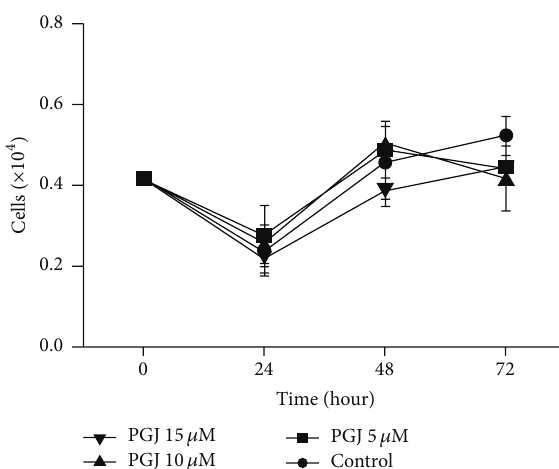
Figure 2: Fibroblast (FG11) cell proliferation under 15d-PGJ 2 treatment. FG11cells were treated with 5 to 15 𝜇 M of 15d-PGJ 2 . The data are presented as means ± standard deviation of three replications from at least three independent tests. 15d-PGJ 2 did not show significant difference from the control at the doses of 5 𝜇 M, 10 𝜇 M, and 15 𝜇 M.